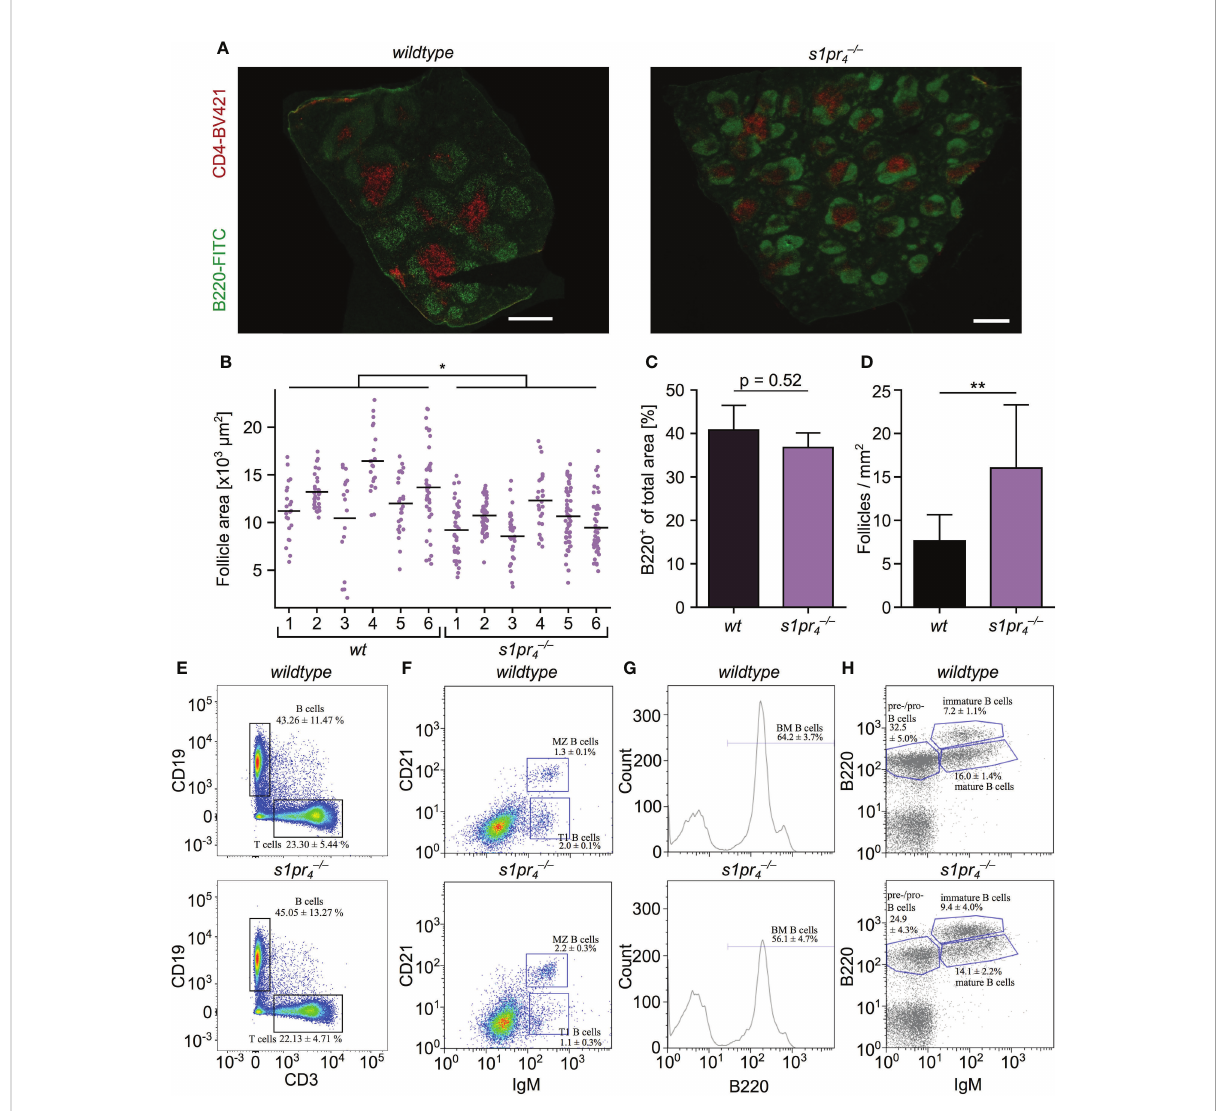
Analysis of the architecture and composition of the spleen. (A) Microscopic structure of spleens of wildtype (wt) and S1PR 4 -de fi cient ( s1pr − = − 4 ) mice stained with anti-B220 (green) and anti-CD4 (red) to identify B zone and T zone, respectively. (B – D) Quanti fi cation of follicle size, density and B220 positive area. Values represent the mean + standard deviation of n = 6 animals per group. (E, F) Flow cytometric analysis of splenic lymphocyte populations. B cells: CD19 + ; T cells CD3 + ; MZ B cells: CD21 hi IgM hi ; transitional type 1 B cells: CD21 lo IgM hi (n = 5 per group). (G) Flow cytometric analysis of bone marrow cells stained with anti-B220 (n = 5 per group). (H) Analysis of B cell subpopulations in the bone marrow. Pre-/pro-B cells: B220 + , IgM – ; immature B cells: B220 int , IgM + ; mature B cells: B220 hi , IgM + (n = 5 per group). White scale bar equals 500 µm. *p< 0.05, **p<